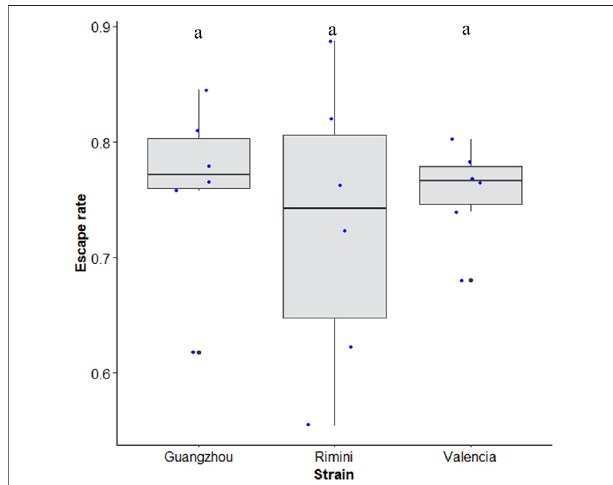
FIGURE 7 | Escape rate of Aedes albopictus strains from different origins (Rimini, Italy; Valencia, Spain; and Guangzhou, China). Black bars indicate the median; the upper and lower limits of each box indicate the interquartile range. Each dot represents a value of the observed escape rate per replicate. Different letters denote signi fi cant differences between strains.